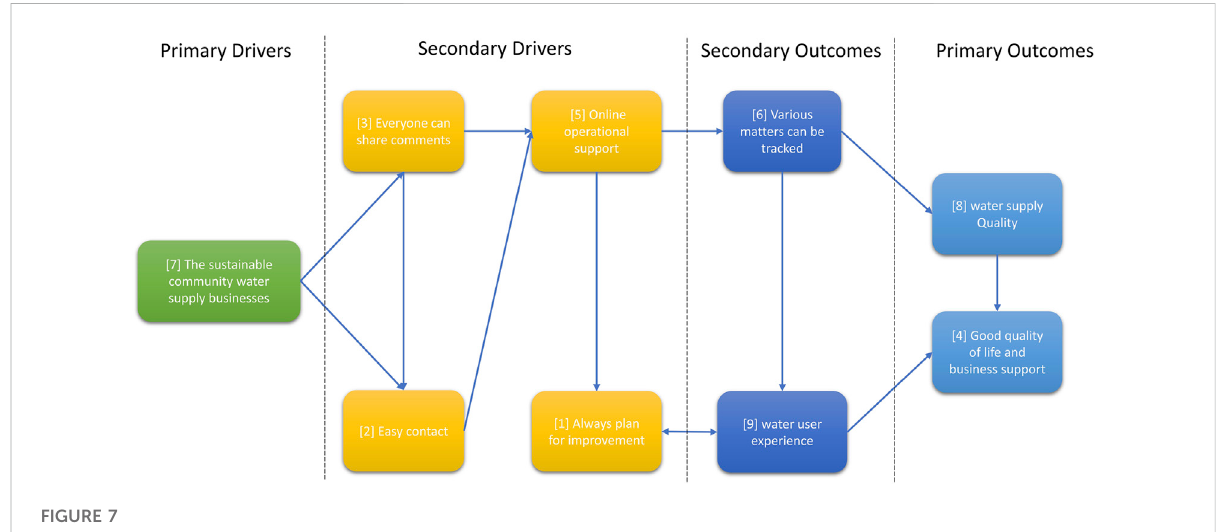
FIGURE 7 Uncluttered system in fl uence